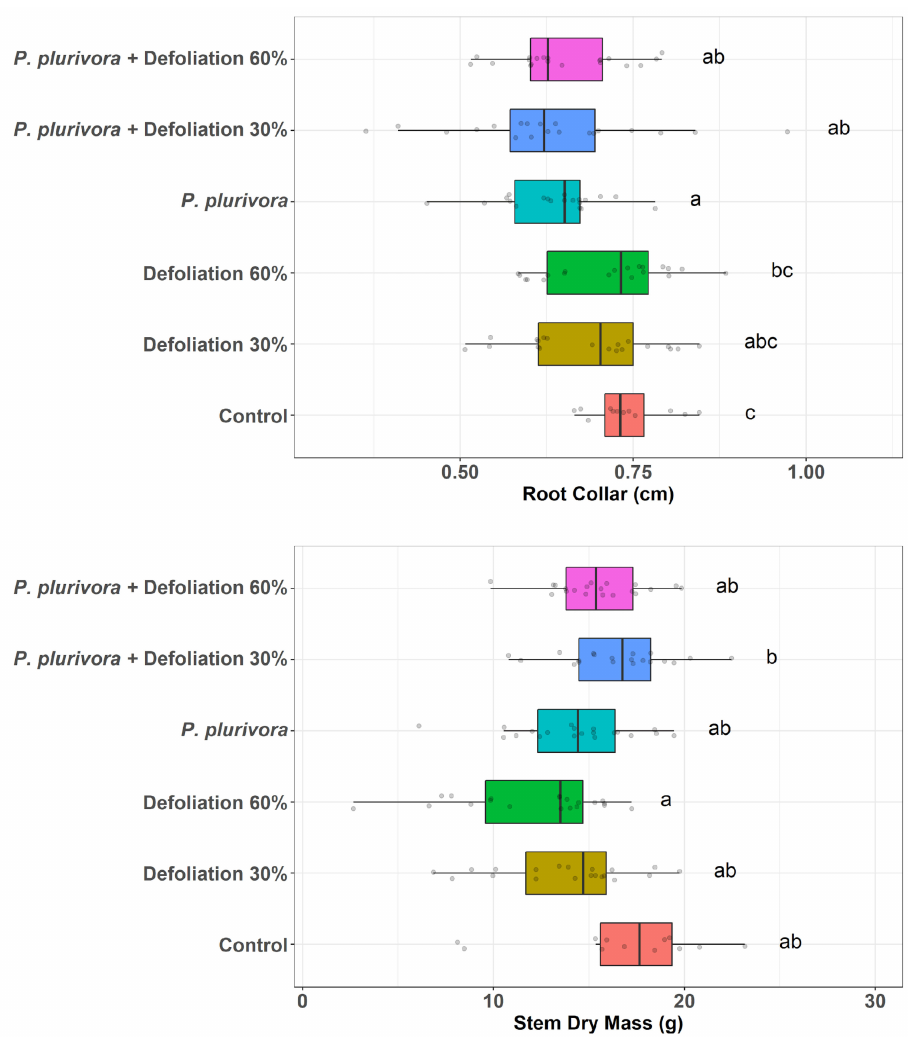
Figure 1. Diameters of the root collar and dry biomass of stems. The lower and upper hinges correspond to the first and third quartiles (the 25th and 75th percentiles), and the center line corresponds to the median. The upper whisker extends from the upper hinge to the largest value no further than 1.5 * IQR from the hinge (where IQR is the inter-quartile range or distance between the first and third quartiles). Likewise, the lower whisker extends from the lower hinge to the smallest value no further than 1.5 * IQR from the hinge. Treatments with different letters in the notation are significantly different. Points were jittered in order to avoid overplotting of identical